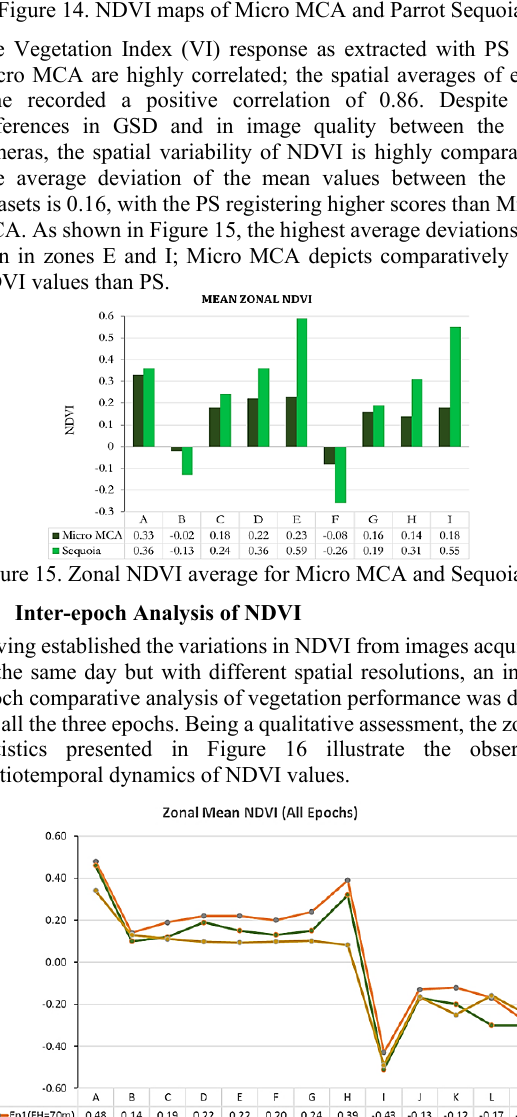
Figure 16. Statistical comparison of NDVI values (Epoch 1 to 3) Spatiotemporal analysis of NDVI depicted a declining trend